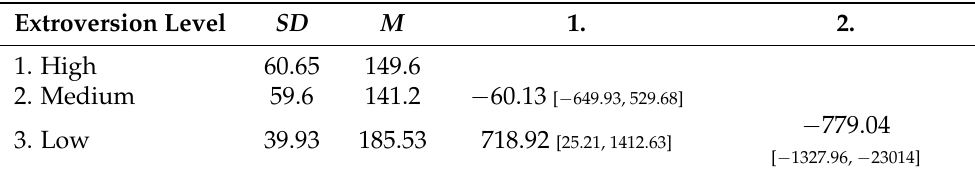
Table A21. Tukey Post Hoc Results of SFN statistic (Freud me out 2) by NEO-FFI Extroversion